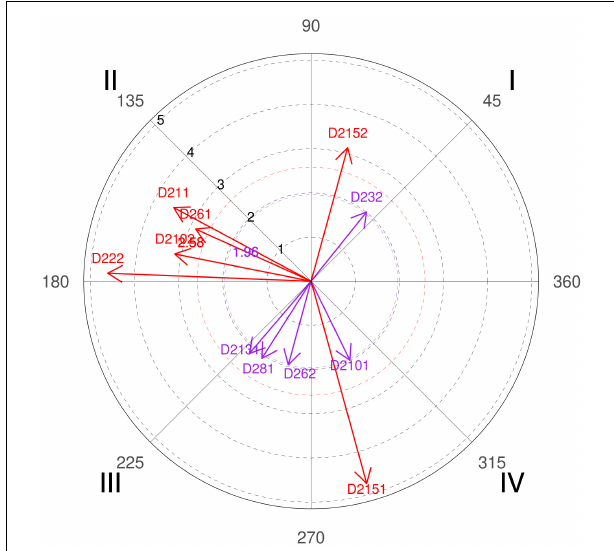
FIGURE 7 | Relationship of conditioned behaviors that present a significant relationship with the focal behavior “favorable evaluation” analyzing question 12 of the in-depth interviews. In “favorable evaluation,” a total of 11 significant vectors were detected.